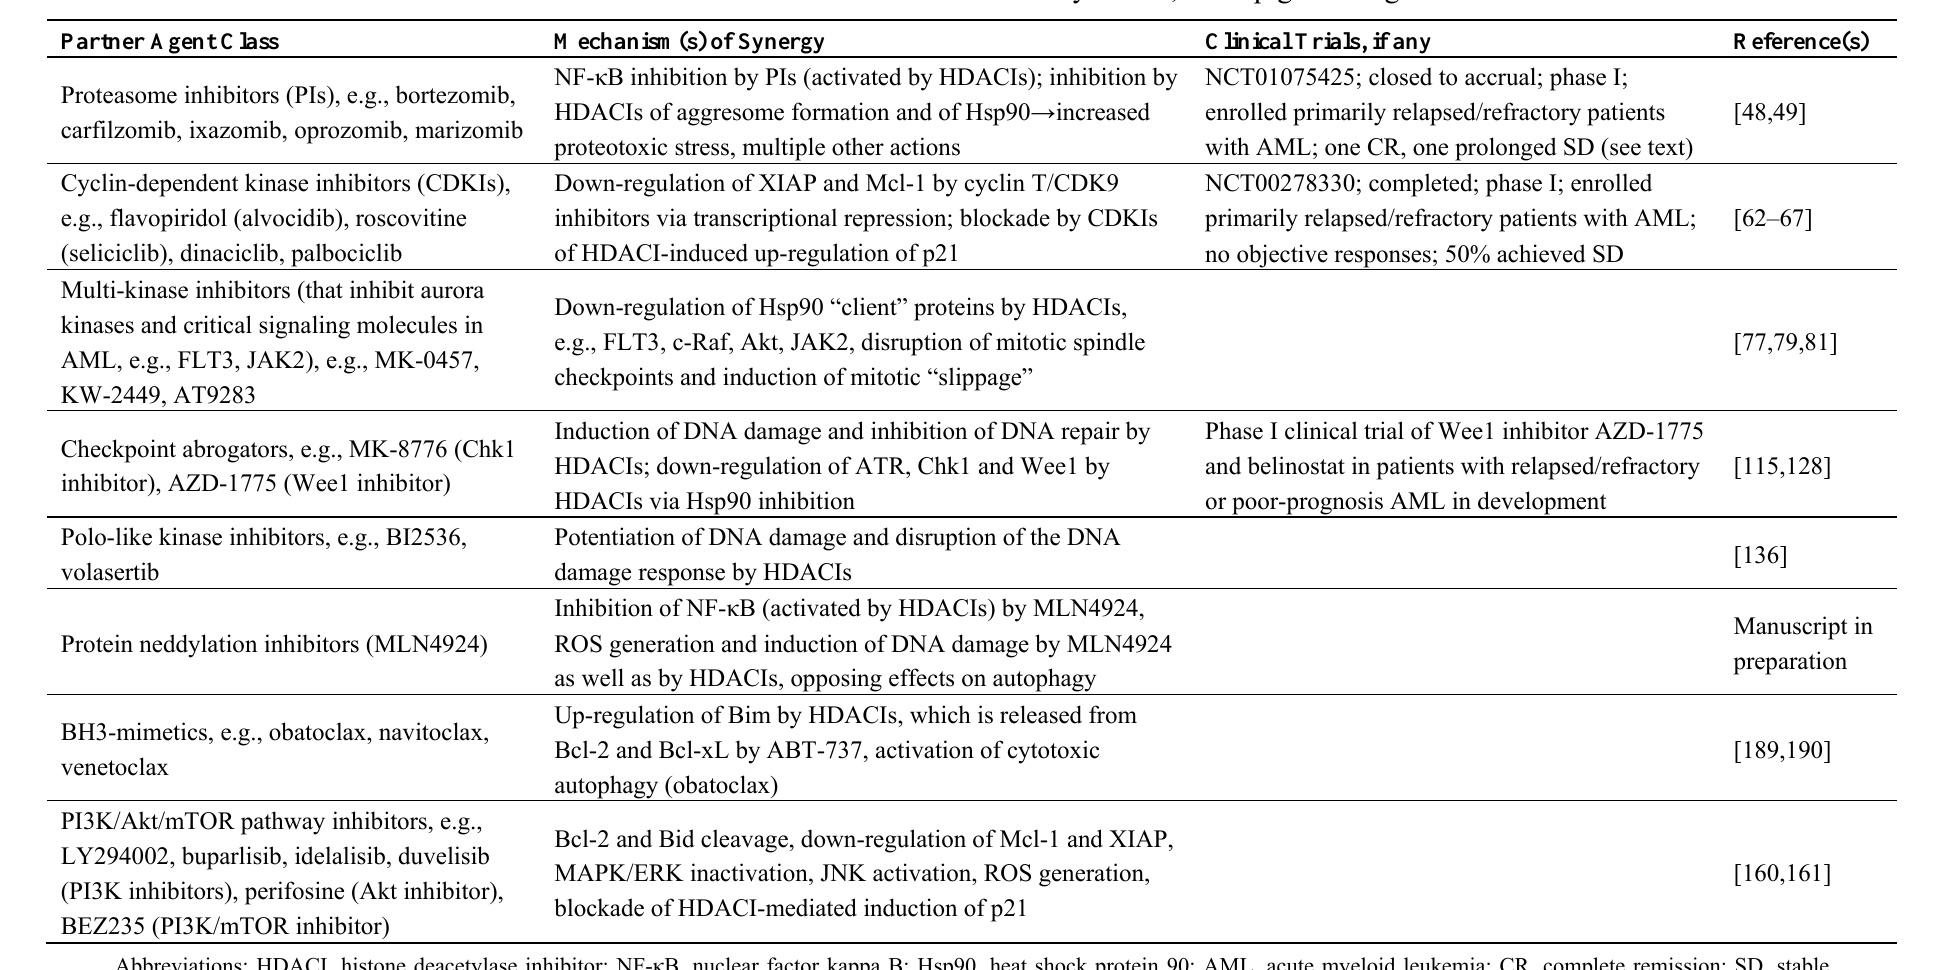
Table 1. HDACI-based rational combinations with non-cytotoxic, non-epigenetic agents in